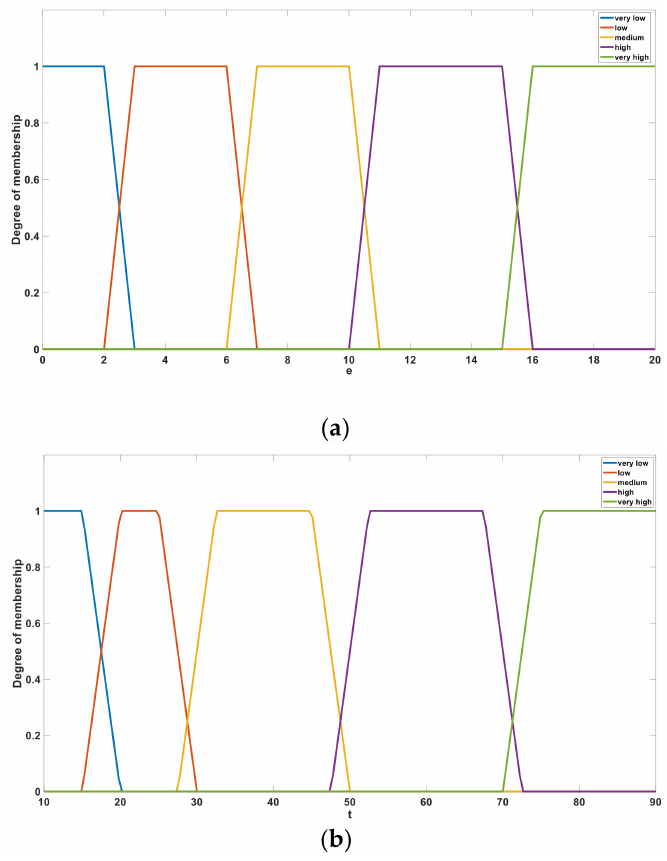
Figure 10. Membership functions of the input variable: ( a ) e and ( b ) t